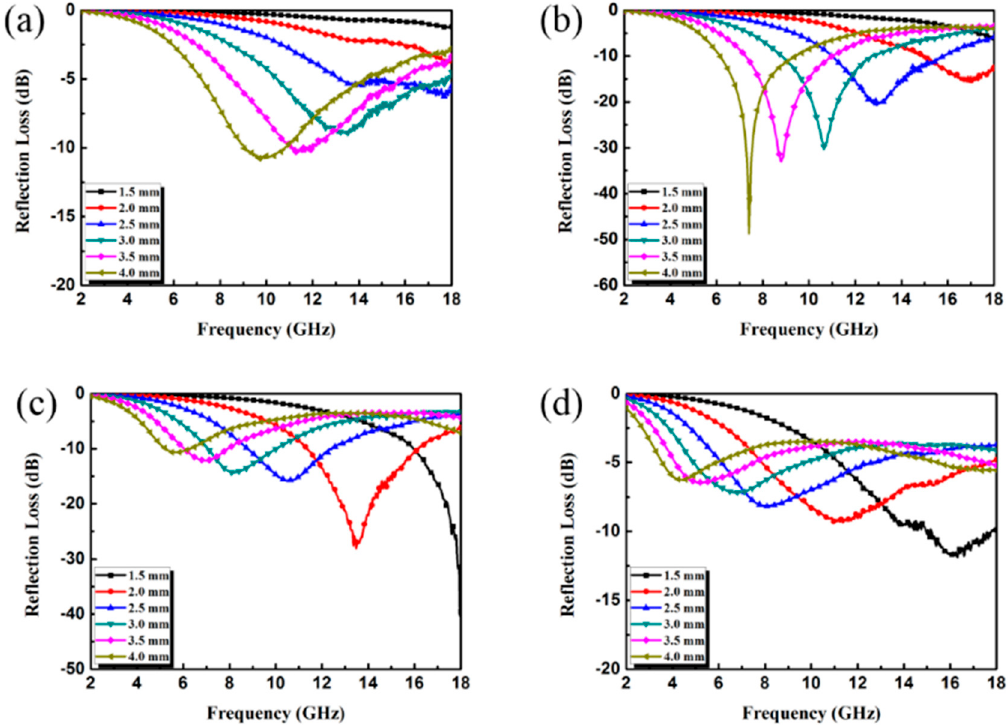
Figure 6. RL curves of paraffin composites containing 5 wt.% ( a ), 10 wt.% ( b ), 15 wt.% ( c ), and 20 wt.% ( d ) of rGO/CuS/PPy.